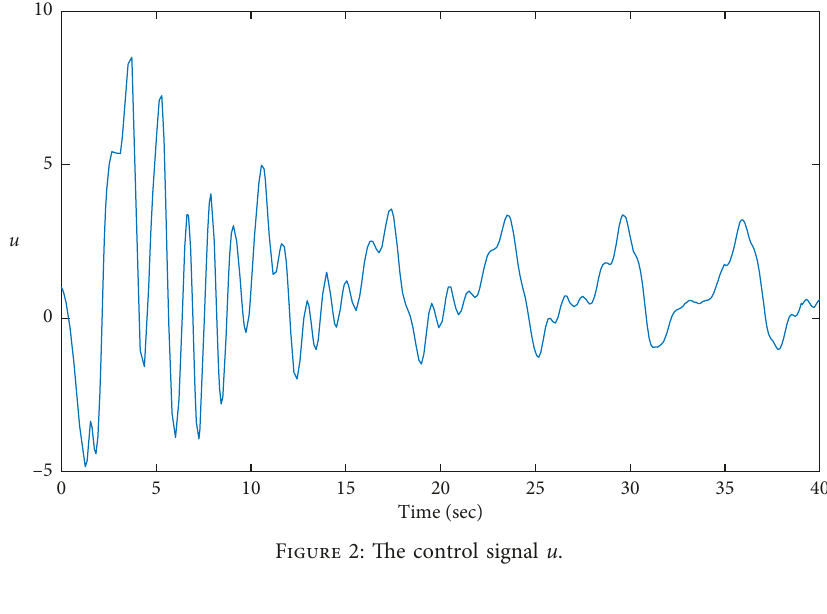
Figure 2: The control signal u .